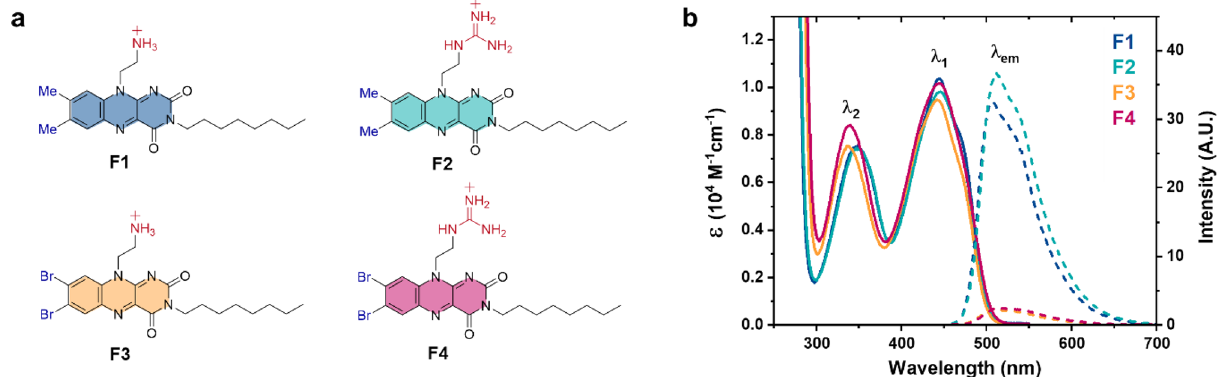
Figure 2. The structures and photophysical spectra of F1-4 . ( a ) Structures of flavins F1-4 (counteranions = TFA - ), ( b ) UV–Vis absorption (bold) and emission (dashed) spectra of F1-4 in